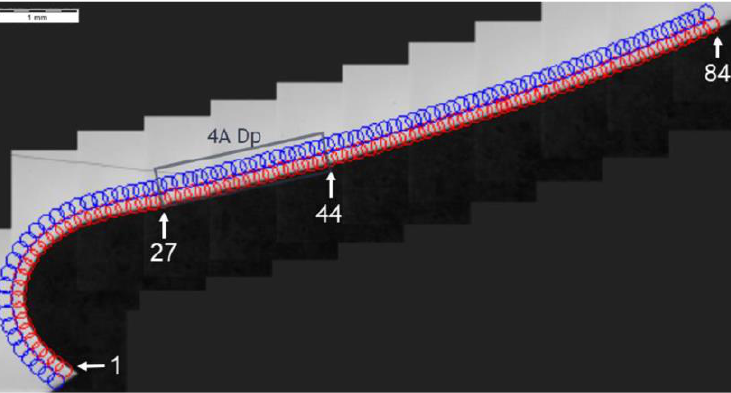
Figure 18. Localization of cross-section H-H, zone: 4A Dp.